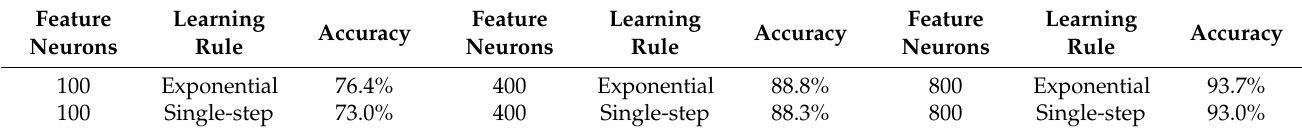
Table 4. Impact of learning rules on